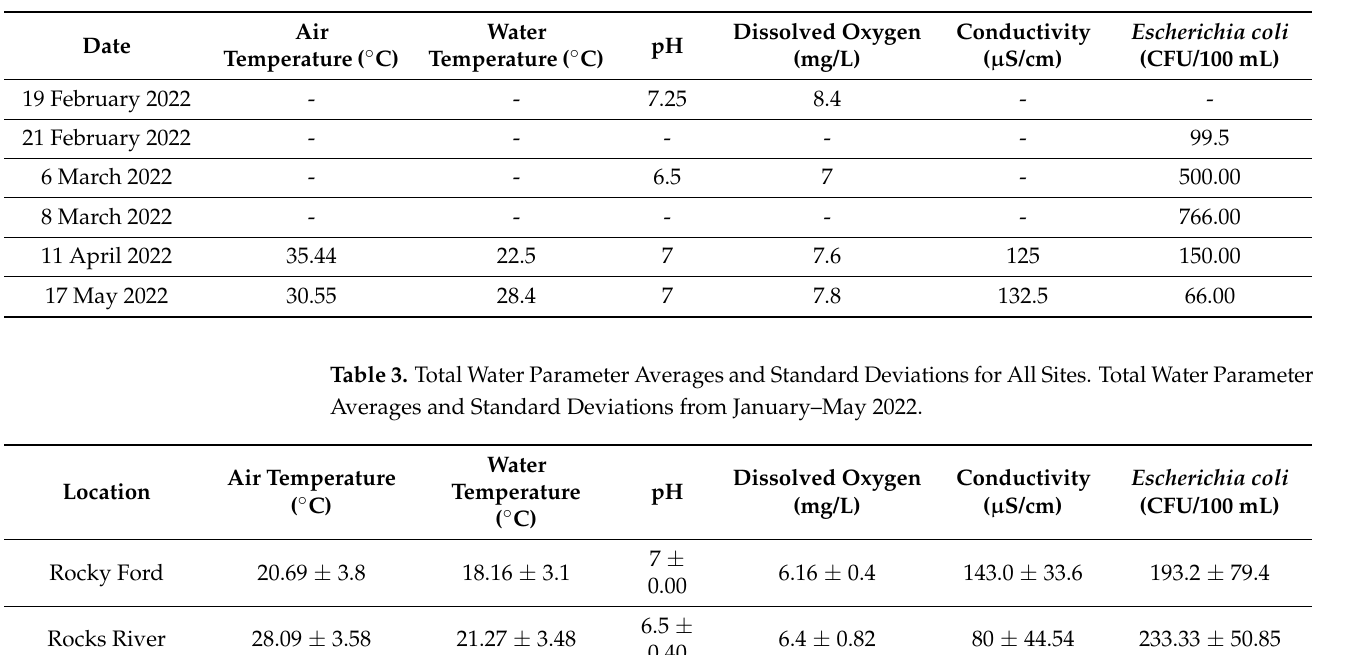
Table 2. Water Quality—Water Sampling Parameter Dates and Measurements for Little Lotts Creek. Average Water Sampling Measurements from Little Lotts Creek.